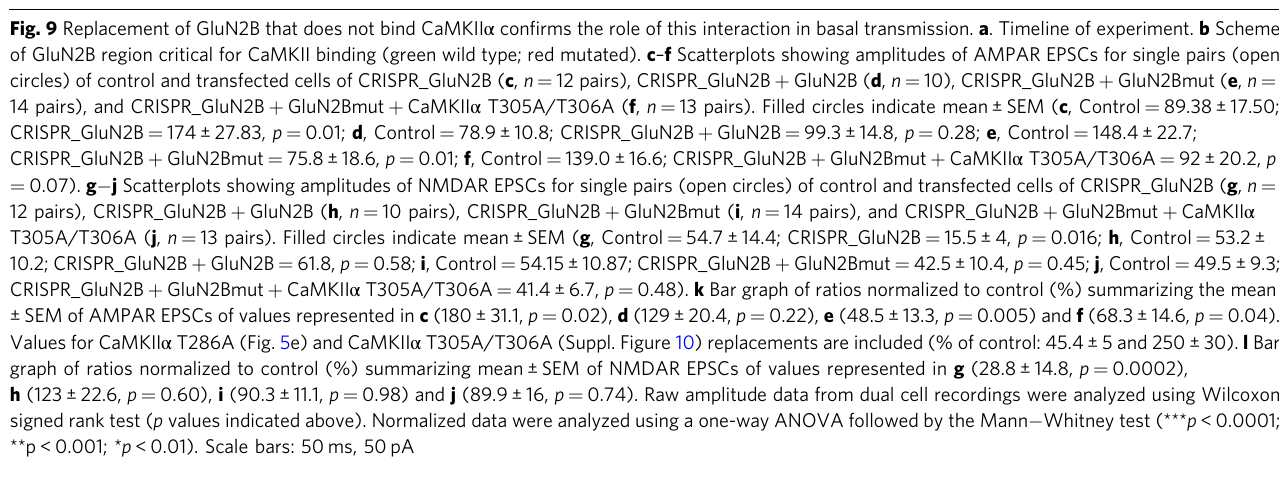
Fig. 9 Replacement of GluN2B that does not bind CaMKII α con fi rms the role of this interaction in basal transmission. a . Timeline of experiment. b Scheme of GluN2B region critical for CaMKII binding (green wild type; red mutated). c – f Scatterplots showing amplitudes of AMPAR EPSCs for single pairs (open circles) of control and transfected cells of CRISPR_GluN2B ( c , n = 12 pairs), CRISPR_GluN2B + GluN2B ( d , n = 10), CRISPR_GluN2B + GluN2Bmut ( e , n = 14 pairs), and CRISPR_GluN2B + GluN2Bmut + CaMKII α T305A/T306A ( f , n = 13 pairs). Filled circles indicate mean ± SEM ( c , Control = 89.38 ±